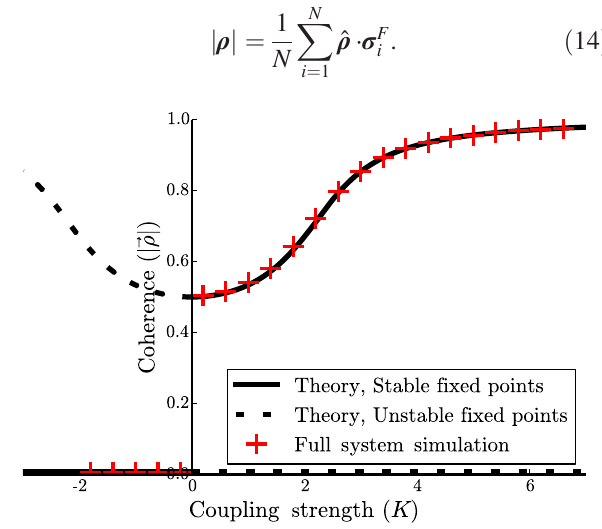
FIG. 6. Phase transition for Kuramoto model generalized to three dimensions. The solid (dashed) black curve represents the derived stable (unstable) fixed points for the order parameter, and the red plus sign markers represent numerical results from a simulation with N ¼ 10 4 agents and Δ ¼ 1